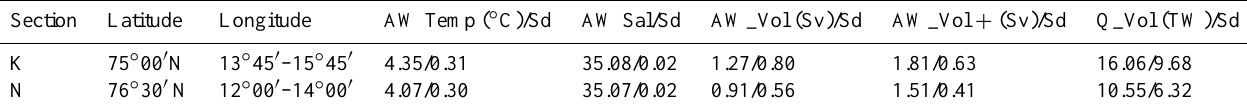
Table 1. Mean properties of AW ( T >2 ◦ C, S >34.90) and baroclinic transports cross the WSC eastern branch at sections K and N. Mean for